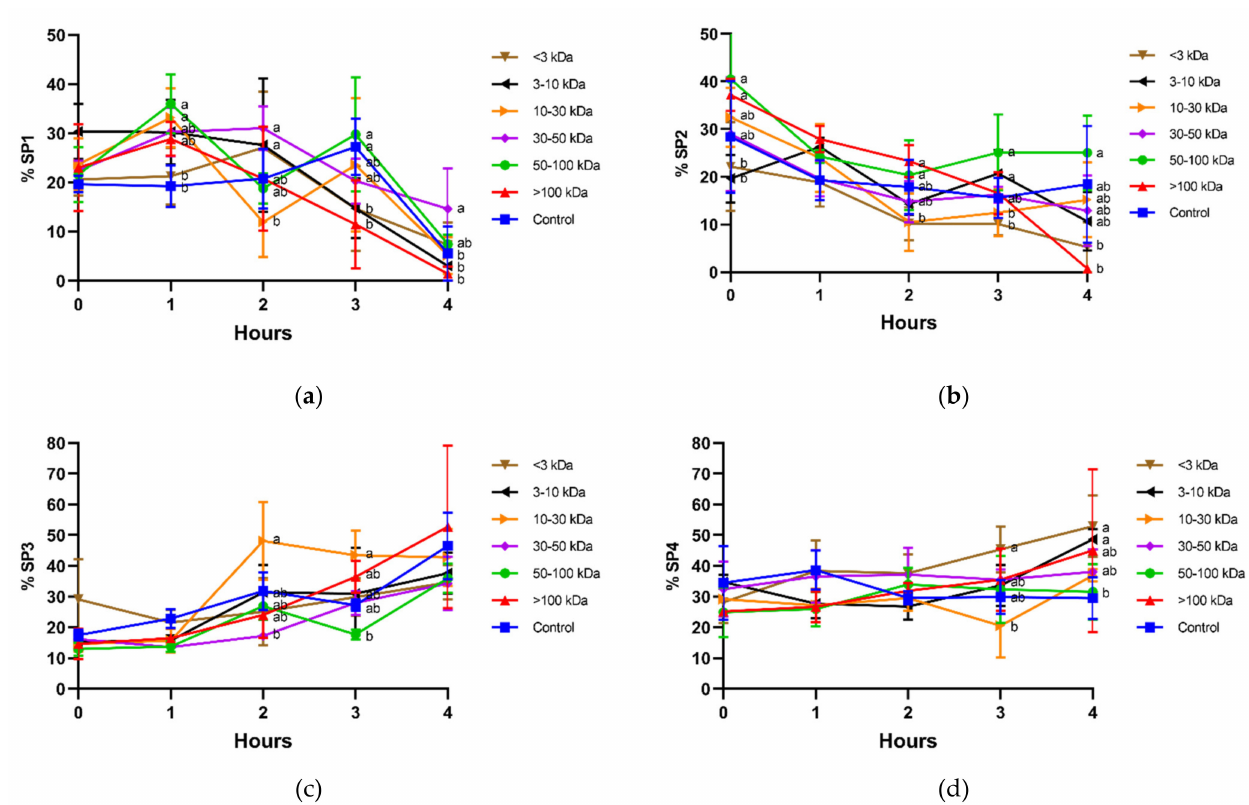
Figure 5. Percentages of motile sperm populations (SP1 ( a ), SP2 ( b ), SP3 ( c ), and SP4 ( d ); unbound sperm) in different seminal plasma fractions and throughout incubation at 38 ◦ C for 4 h. Different superscripts (a,b) mean significant differences between seminal plasma fractions within a given time point ( p ≤ 0.05). Data are shown as mean ± SD for 12 independent